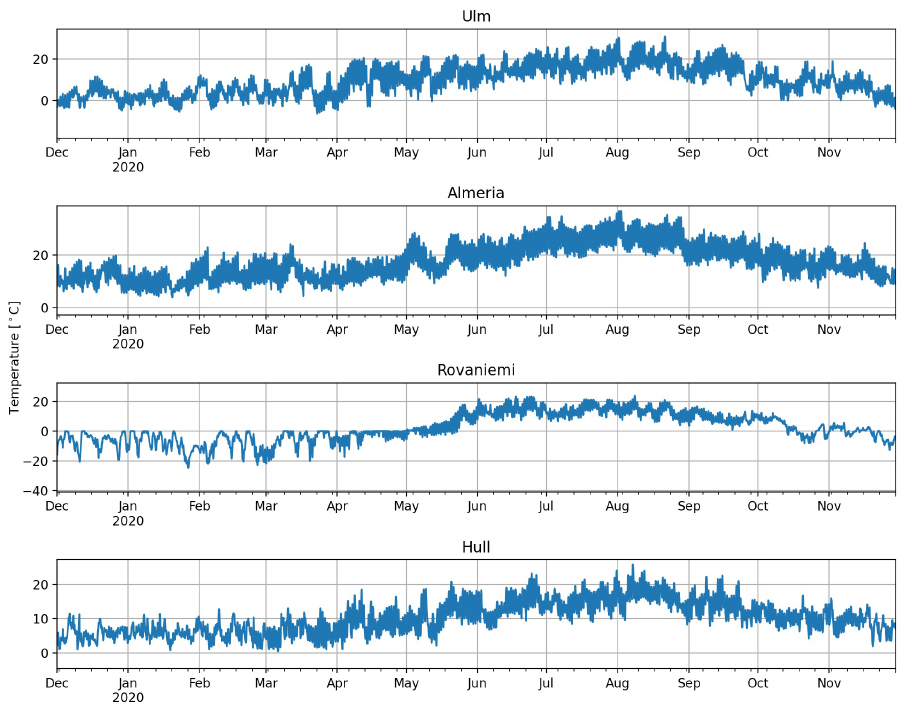
Figure 3. Temperature from 1 December 2019 to 30 November